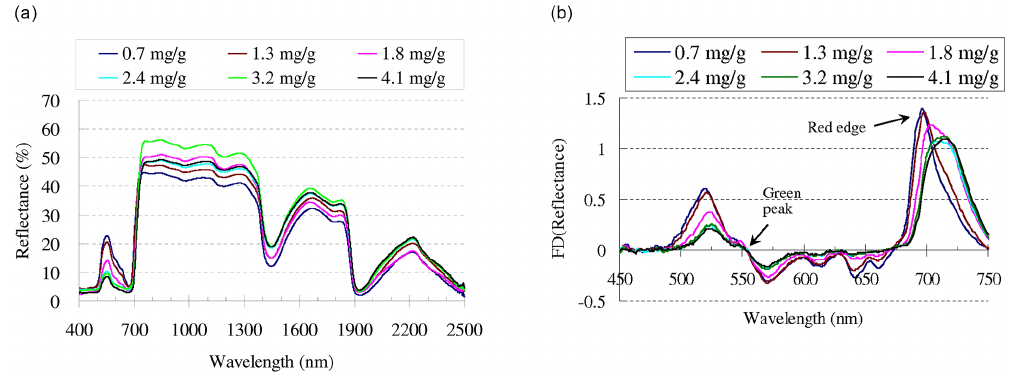
Figure 2. Foliar reflectance spectra of Cinnamomum camphora . (a) Spectral curves showed the reflectance variation of visible–infrared bands due to the changes of foliar chlorophyll concentration. (b) Association between the chlorophyll concentration and the green peak and red edge spectra of fresh